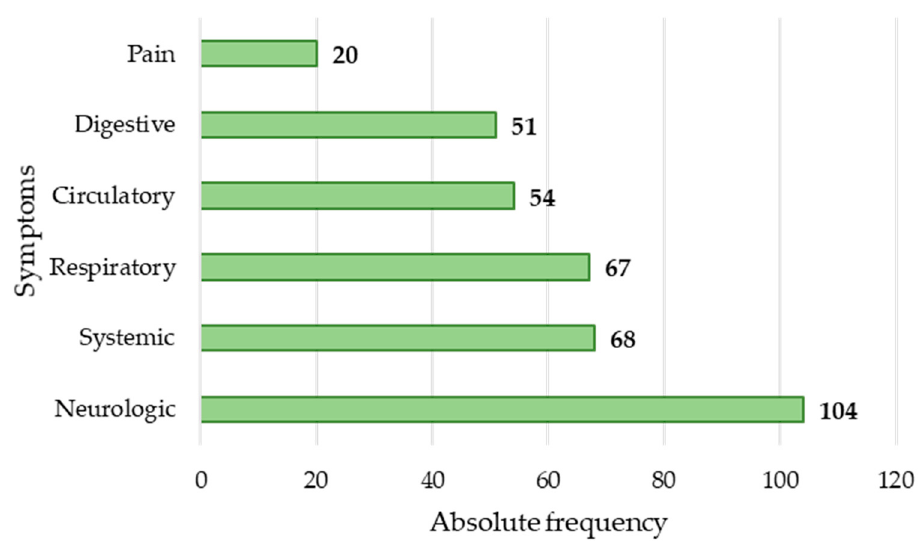
Figure 3. Absolute frequency of symptoms. A psychiatric anamnesis was collected in only 10 cases of ingestion for suicidal pur- poses. The psychiatric histories included depression (7; 70%), previous suicide attempts (6; 60%), bipolar disorder (2; 20%), schizophrenia (1; 10%), paranoia (1; 10%), previous self-harm attempts (1; 10%), and post-traumatic stress disorder (1; 10%).